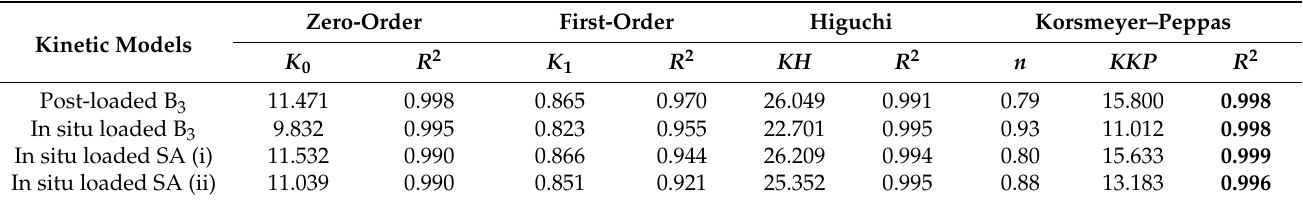
Table 5. Active release kinetics illustrate the (R 2 ), release rate constants ( K ) and release exponent ( n ) value for the